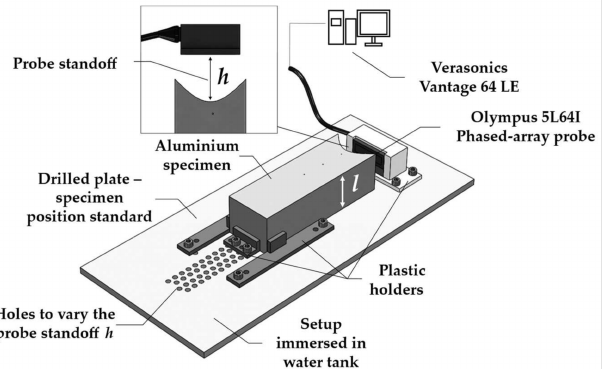
Figure 5. Schematic of the experimental setup used to validate the optimization calculations. The setup was assembled using 3D-printed plastic